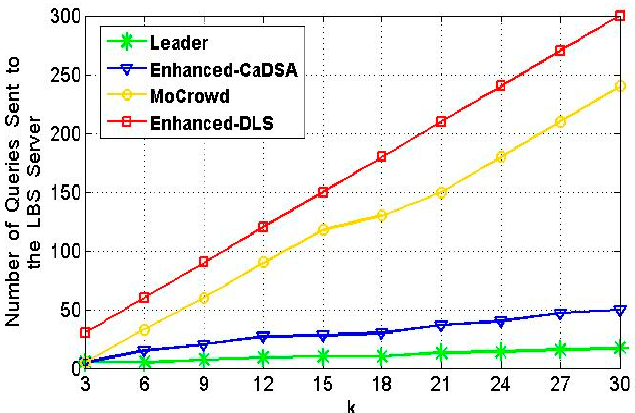
Figure 12. Communication cost VS. Anonymity level.